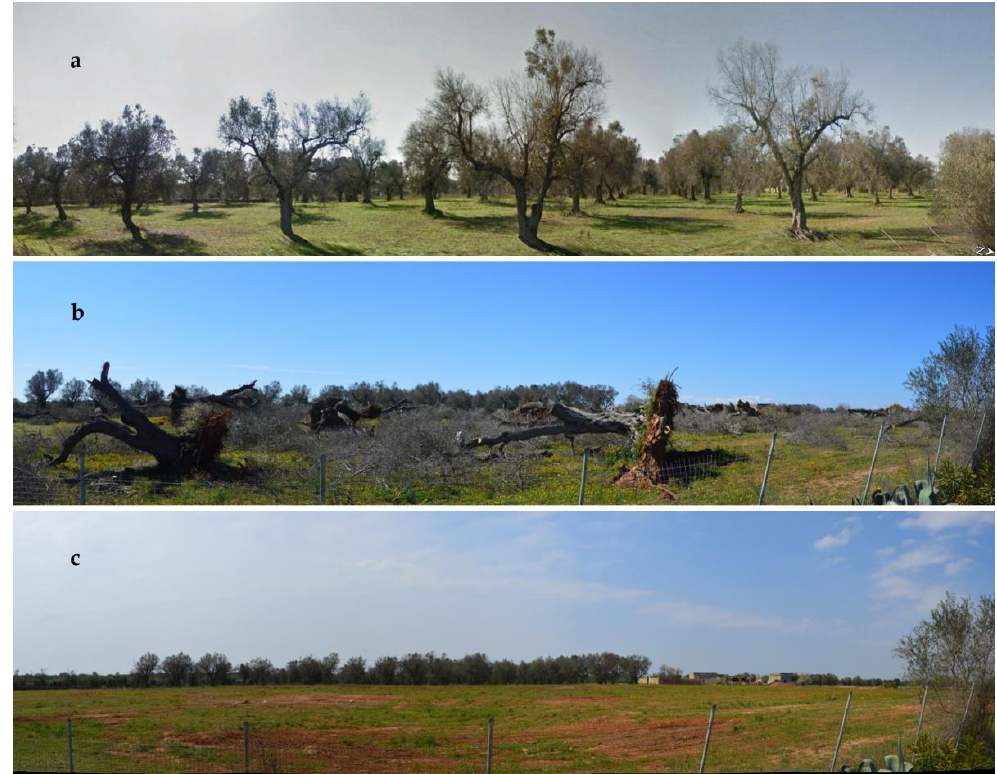
Figure 2. Example of eradication activity carried out in the early 2019. The scenarios represent the short- and medium-term transformation considered for the qualitative analysis of the change in ecosystem services caused by X. fastidiosa. ( a ) Picture of olive trees affected by X. fastidiosa (December 2018), ( b ) same as ( a ), but after eradication (February 2019), ( c ) same as ( a ) but some months after eradication (April 2019).